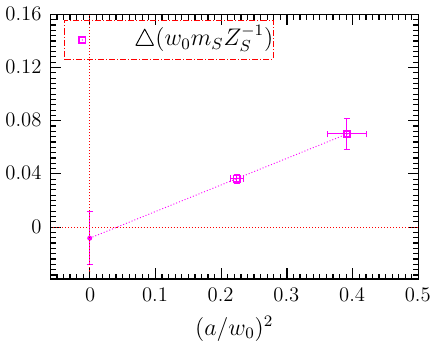
) at vanishing m 2 a– π as a S